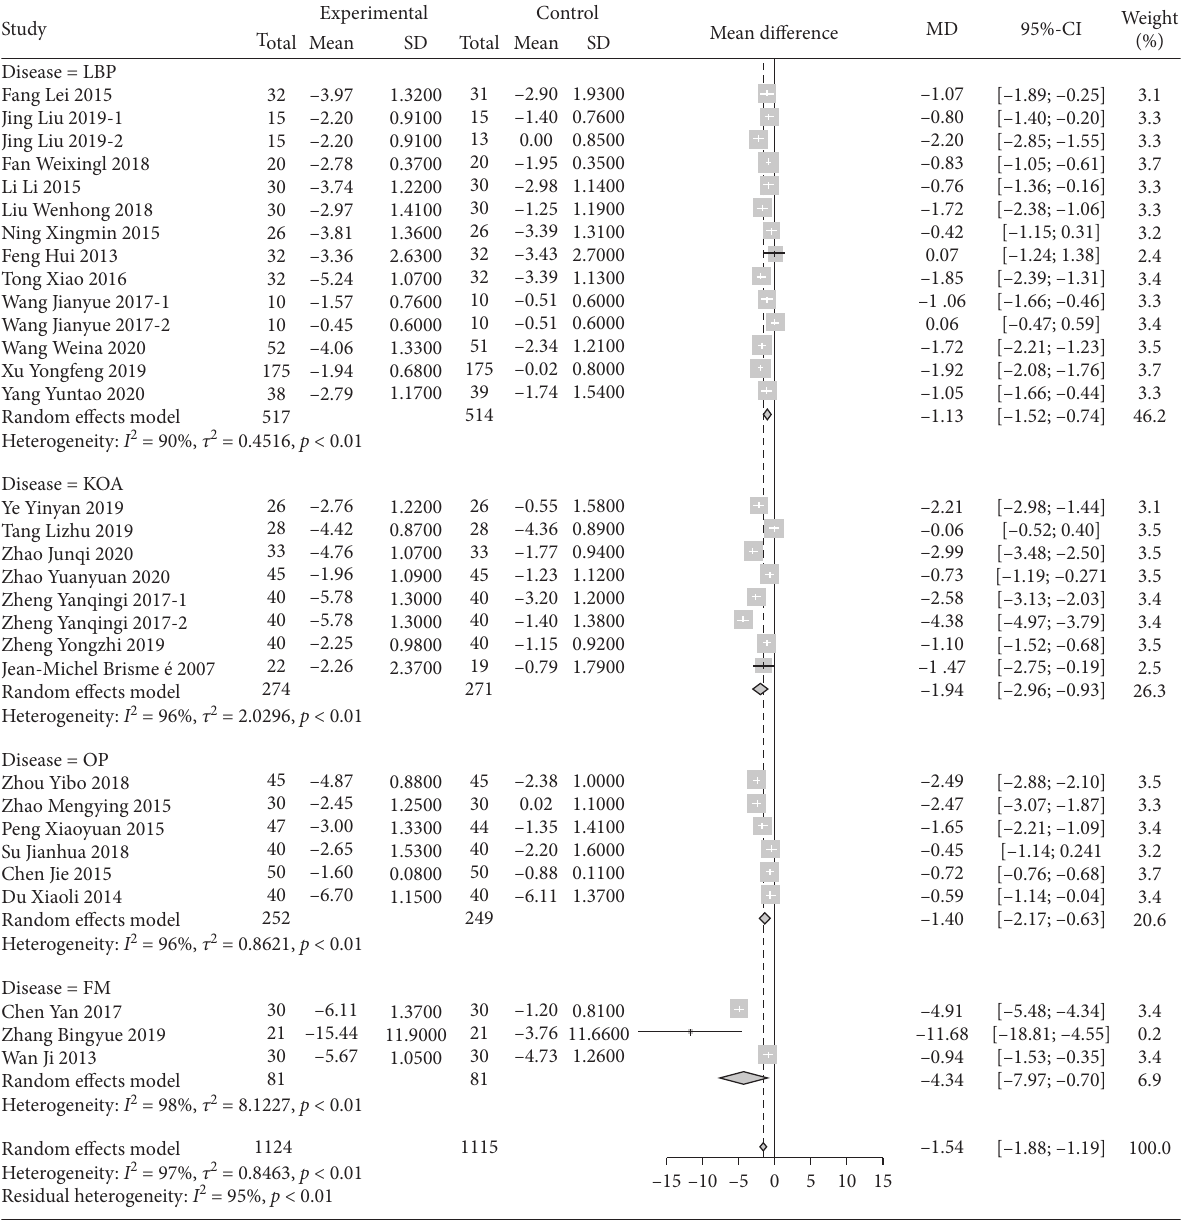
Figure 5: Subgroup analysis of the comparison of pain VAS scores of different diseases.